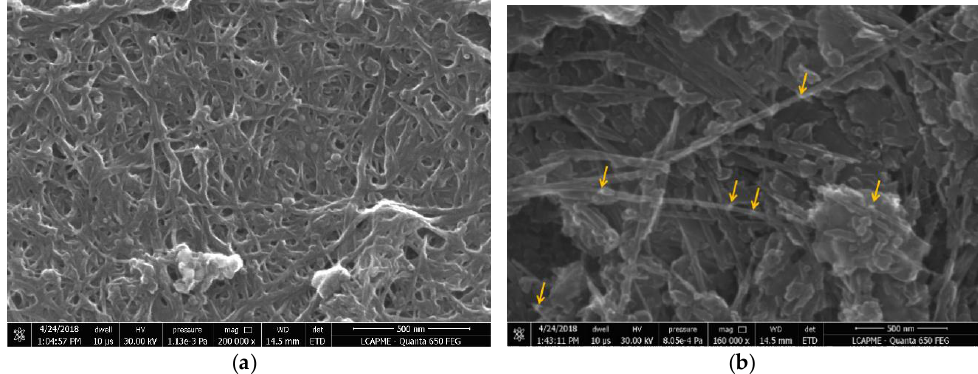
Figure 2. SEM morphologies for: ( a ) MWCNT-COOH and ( b ) MWCNT-COOH-CDDP. Yellow arrows indicate some examples of granular structures of MWCNT-COOH-CDDP.